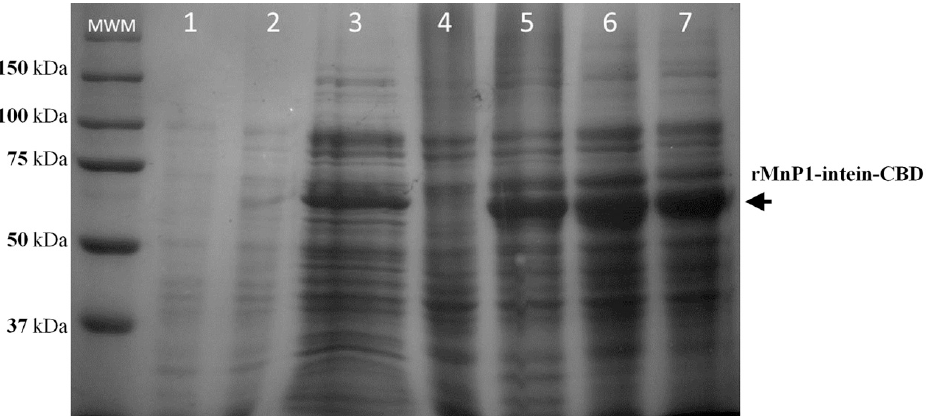
Figure 4. Solubilisation of MnP1-Intein-CBD fusion from inclusion bodies. SDS–PAGE analysis of the insoluble fraction treated with buffer containing 4 or 8 M urea. When cultures reached an OD 600nm of 0.5, they were induced with 0.1 mM of IPTG and incubated at 37 °C for 12 h. Lane 1 : Uninduced cells. Lane 2 : Induced cells. Lane 3 : Whole cell lysate. Lanes 4 and 5 correspond to soluble fraction and inclusion bodies, respectively. Inclusion bodies were treated with 4 M or 8 M urea (Lane 6 and 7, respectively). MWM: Kaleidoscope Protein Standard.